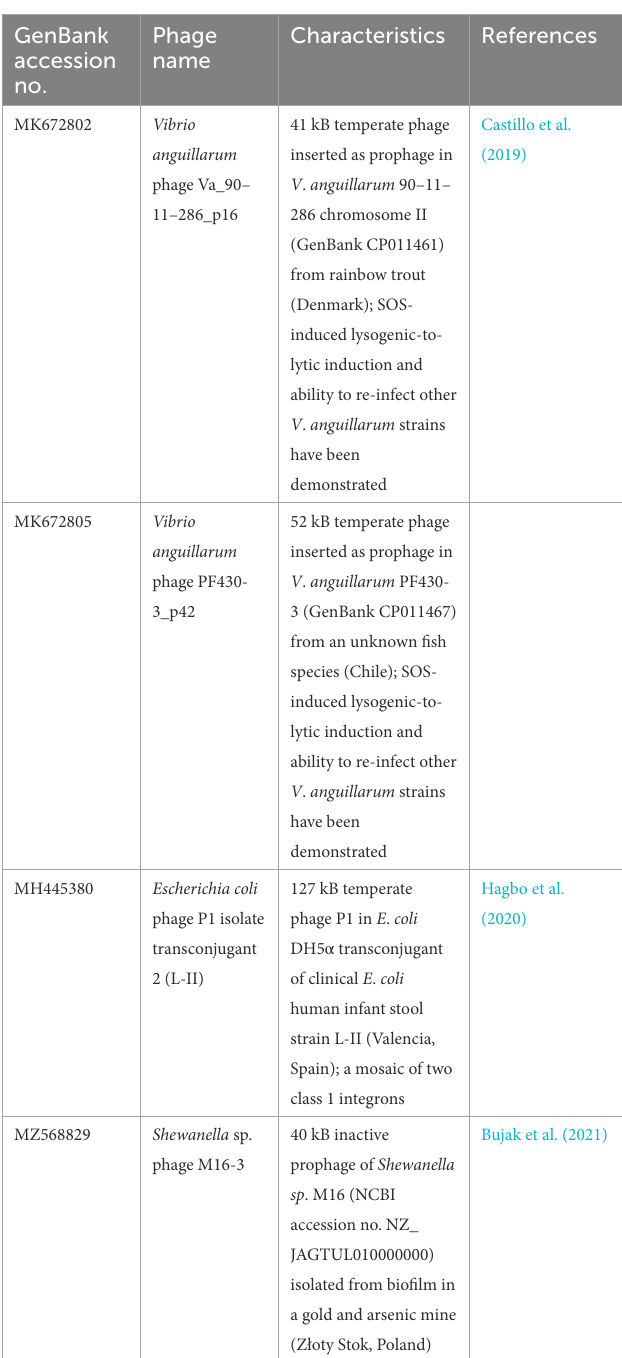
TABLE 1 Temperate phage genomes with complete integrons and In0 element (integron-integrase that does not carry gene cassettes) as predicted by IntegronFinder (Neron et al.,